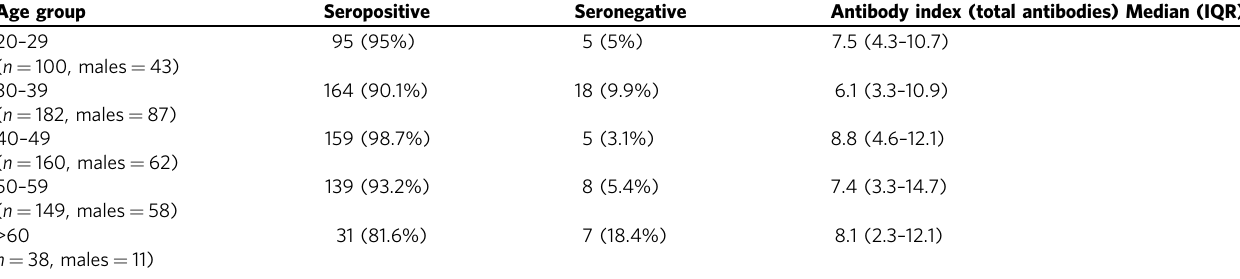
Table 1 Seropositivity rates of a single dose of the ChadOx1 between 28 and 32 days in HCWs who were seronegative at